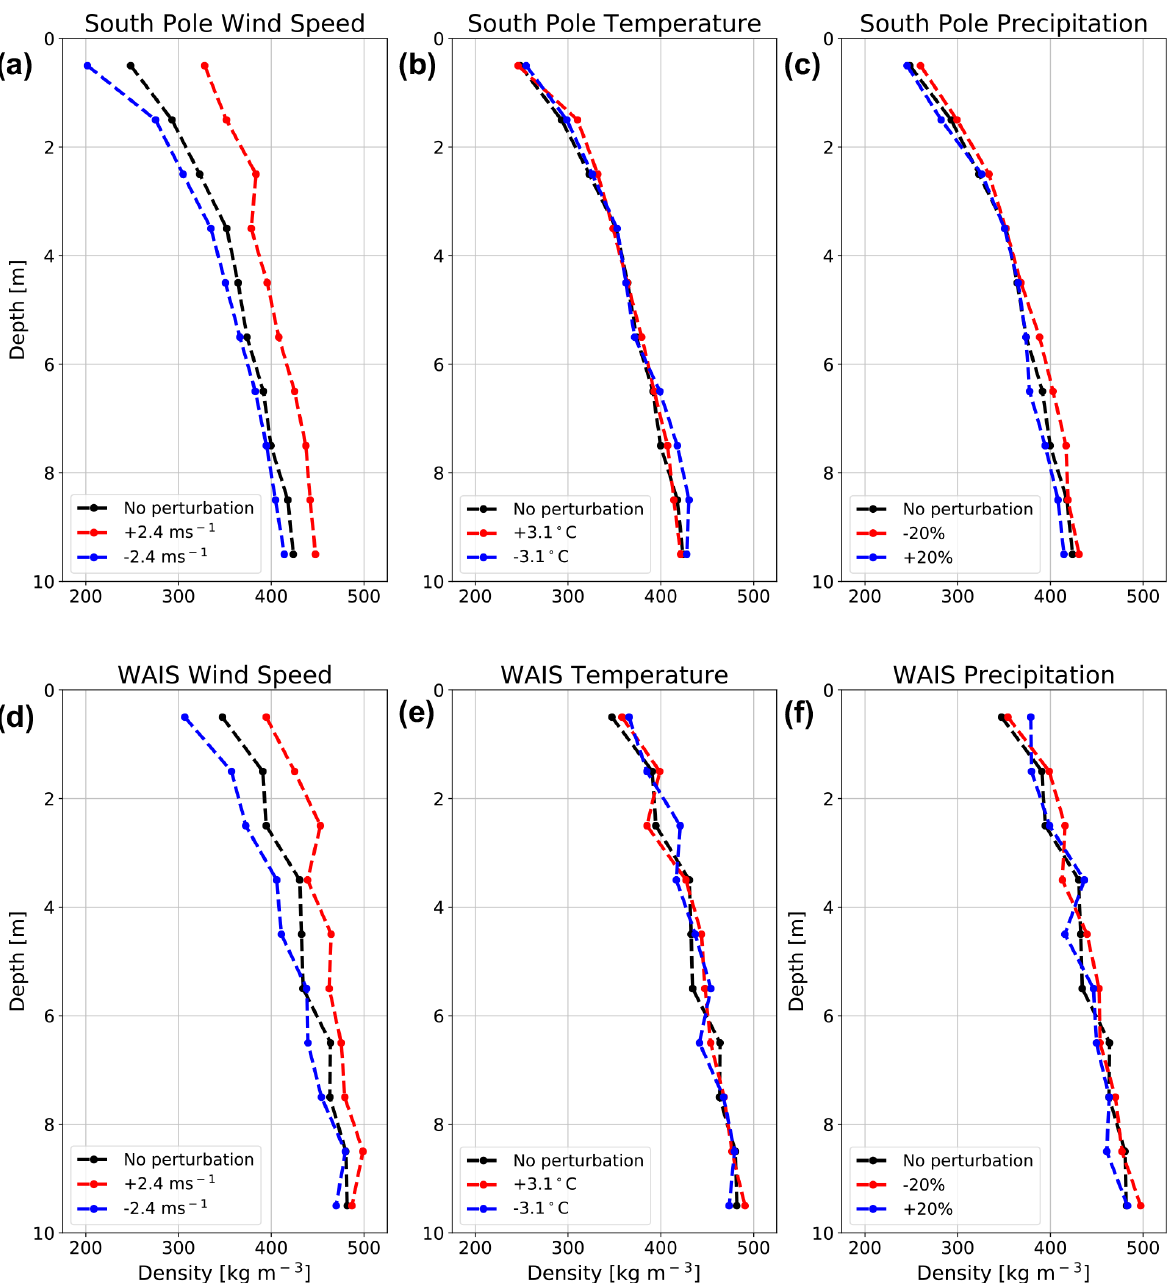
Figure 5. SNOWPACK-simulated density profile sensitivity to uncertainties in atmospheric forcing. SNOWPACK-simulated density profile sensitivity at the South Pole (a–c) and WAIS (d–f) , to wind speed (a, d) , temperature (b, e) , and precipitation (c, f) . The increased wind speed ( + 2 . 4ms − 1 ), increased temperature ( + 3 . 1 ◦ C), and reduced precipitation ( − 20%) perturbations are shown in red, while decreased wind speed ( − 2 . 4ms − 1 ), decreased temperature ( − 3 . 1 ◦ C), and increased precipitation ( + 20%) perturbations are shown in blue. In all panels, density profiles are valid for 31 December 2017, and black curves represent unperturbed atmospheric forcing simulations.